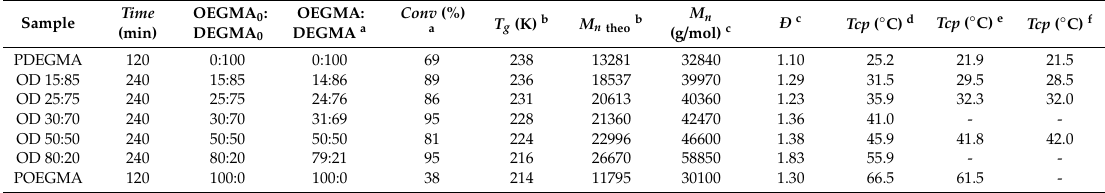
Table 2. Collection of results from the polymers and copolymers synthesized using APP as